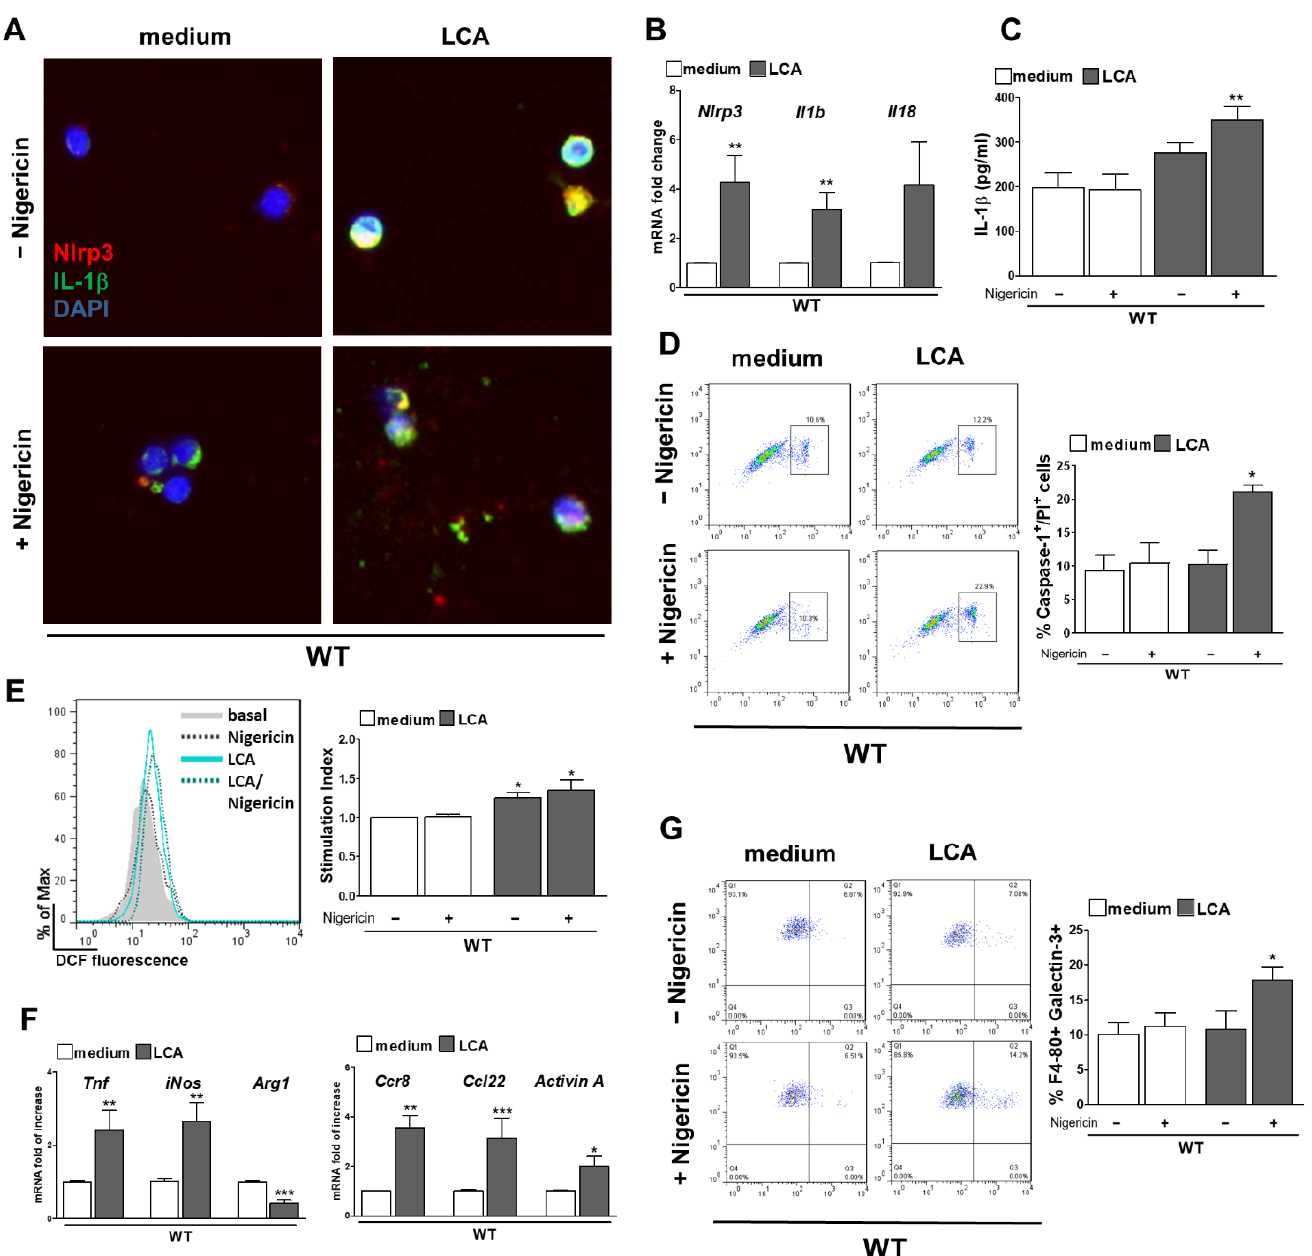
Figure 6. LCA stimulates NLRP3 activation in KC and provokes a pro-inflammatory phenotype. Stimulation of KC with LCA (+ Nigericin) activates the NLRP3 inflammasome as validated by increase of mRNA of Nlrp3 , Il-1b and Il-18 ( B ) and elevated levels of intra- and extracellular IL-1 β ( A , C ). After exposure to LCA + Nigericin more Caspase-1/PI double positive cells were noted in FACS ( D ), which indicates pyroptotic cell death. Assessing possible pathways of NLRP3 activation, measurement of DCF fluorescence in KC showed an increase of ROS production after LCA (+ Nigericin) ( E ). Markers of proinflammatory macrophages ( Tnf, iNos, Ccr8, Ccl22 and ActivinA ) increased after LCA stimulation, whereas expression of ArginaseA as marker for anti-inflammatory macrophages was decreased ( F ). More Galectin 3-positive KC were found after stimulation with LCA + Nigericin compared to medium ( G ). * p <0.05; ** p <0.01; *** p <0.001 However, Nlrp3 − / − KC did not respond with upregulation of proinflammatory markers to ROS as expression of Tnf, iNos, Ccr8, Ccl22 and ActivinA remained at basal level